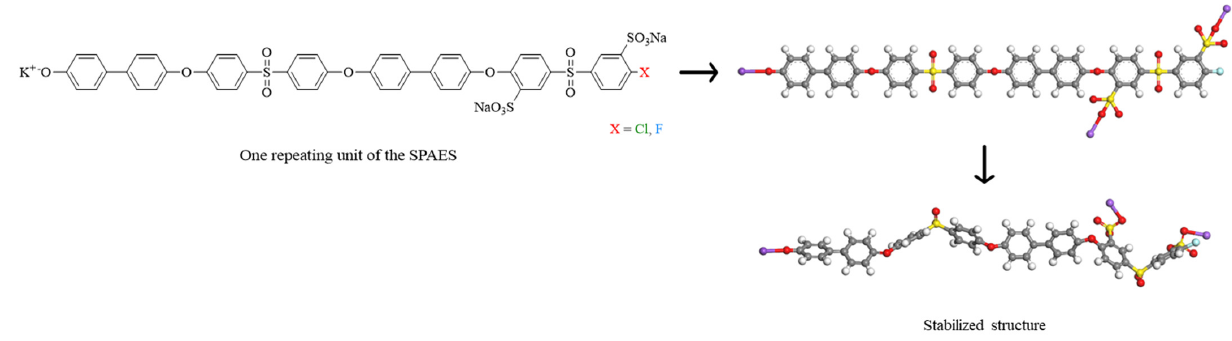
Figure 6. Structural optimization process of one repeating unit of the SPAES copolymer.